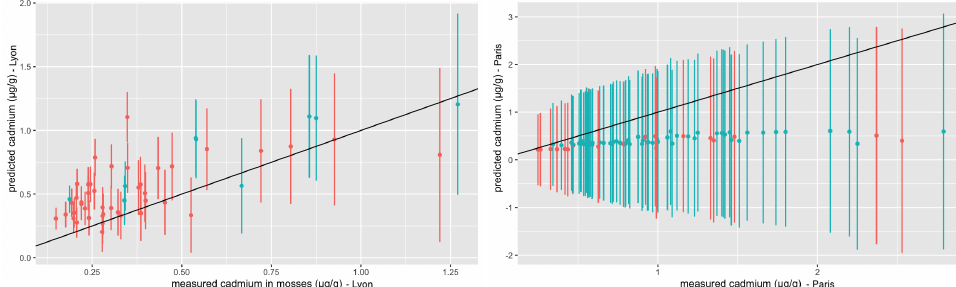
Figure 8. Predictions of Cd in mosses by the model taking into account the measurement uncertainty provided as well as their confidence intervals. On the left (resp. right): prediction of cadmium in Lyon (resp. Paris) mosses by the model trained on Paris (resp. Lyon) mosses. The line corresponds to the line y = x . Red (resp. Blue) is used when the support of the the corresponding moss is a wall (resp. a